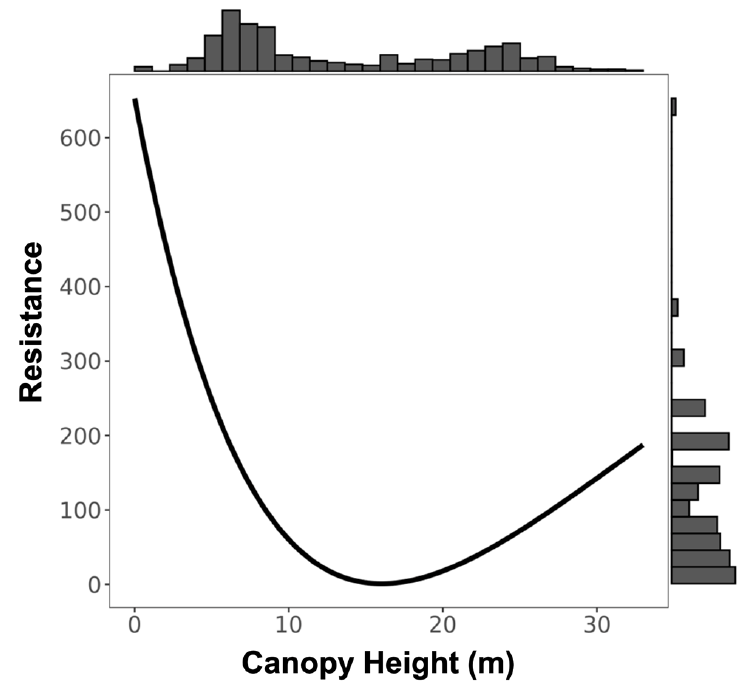
Figure 3. Resistance transformation plot for single surface Terrain Ruggedness Index (TRI). Low TRI values represent relatively flat terrain and high values represent rugged areas. Resistance to ruffed lemur movement was greater in flat (low value) and rugged (high value) terrain.